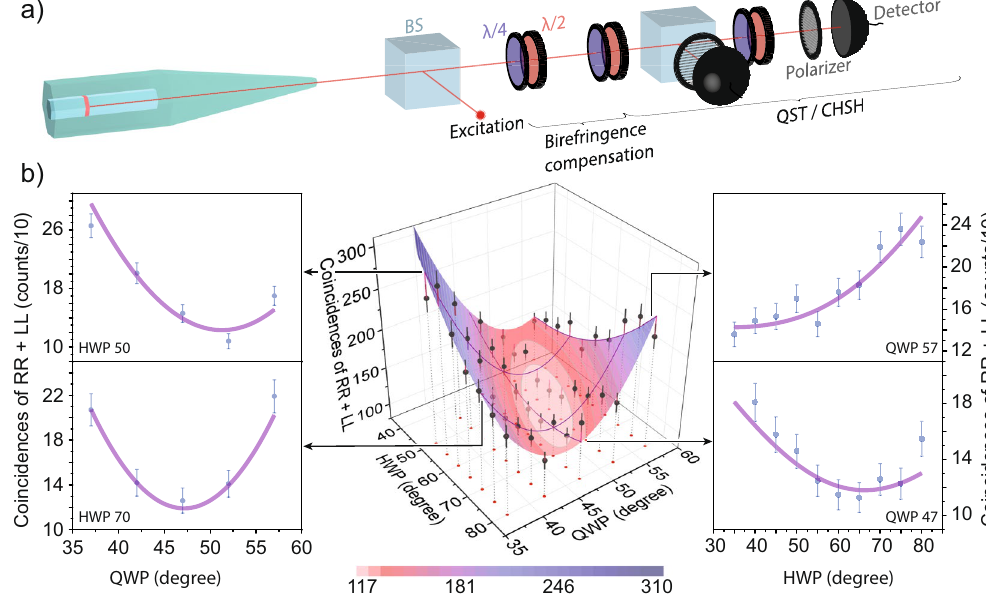
Figure 2. ( a ) Experimental setup for the Bell test and quantum state tomography (QST), including beam splitter (BS), half waveplates ( λ /2), quarter waveplates ( λ /4), polarizers and single-photon detectors. The first set of quarter and half waveplates is used to compensate the quantum state rotation introduced by the possible nanowire birefringence. ( b ) 3D map showing the sum of coincidences at zero time delay for |RR 〉 and |LL 〉 correlations (black dots) as a function of quarter waveplate (QWP) and half waveplate (HWP) angles. Using a color-coded cosine surface fit we found the optimum waveplate configuration to compensate for the state rotation (minimum correlations in RR and LL ). Slices of the 3D map at constant HWP (QWP) angles are shown on the left (right) illustrating the good agreement between the fit and